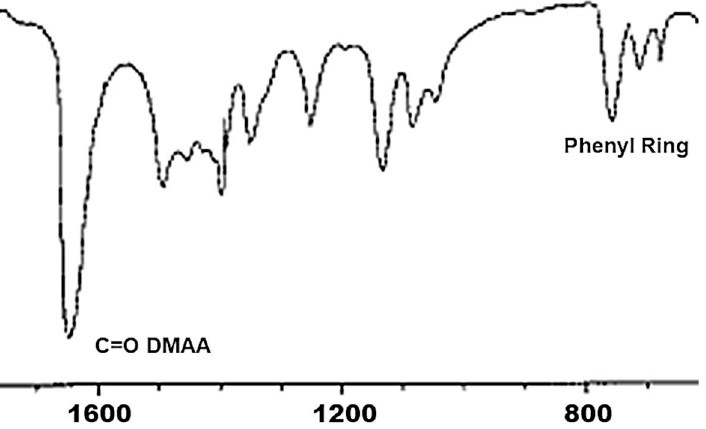
Figure 3. Significant part of FTIR spectrum of P5.